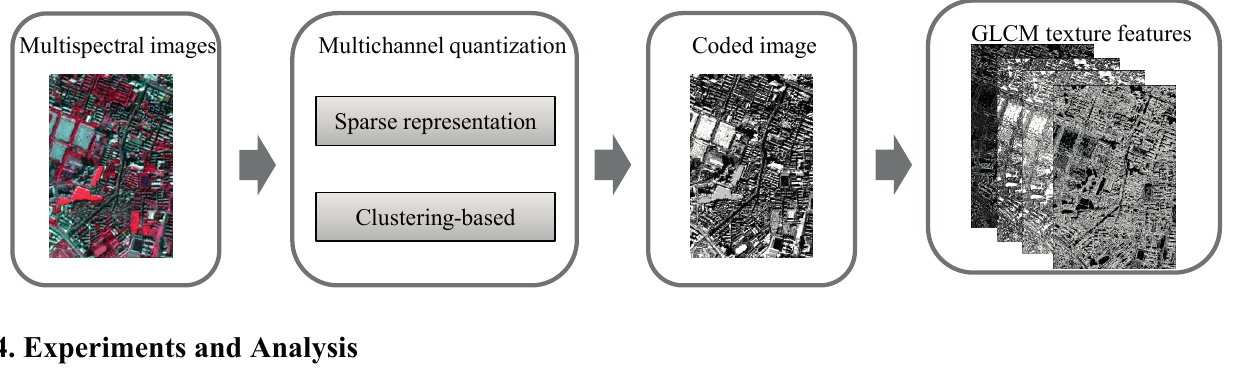
Figure 1. General framework of the multichannel GLCM texture